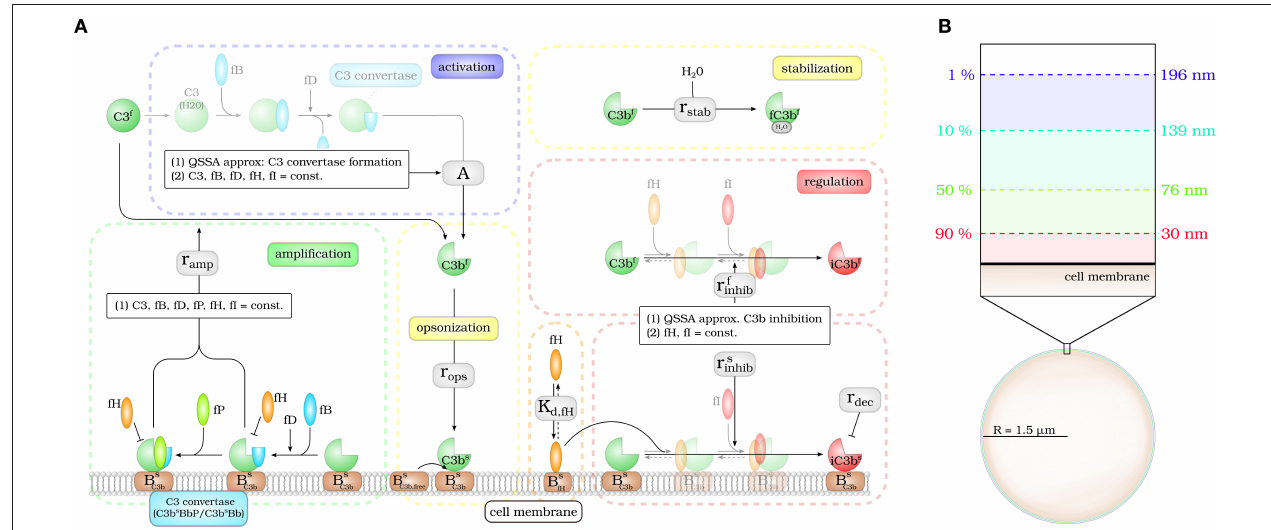
FIGURE 1 | Hybrid differential equation model of the complement system. Complement activation can be divided into five parts: (i) activation, (ii) opsonization, (iii) stabilization, (iv) amplification, and (v) regulation. (A) The model focuses on the dynamics of the central component C3b : Active C3b in the fluid phase, C3b f , results from cleavage of precursor molecule C3 f . The interaction of the fluid phase molecule C3b f with the cell surface is modeled by the interaction with free surface binding sites B s C3b , free and binding sites B s C3b that are occupied with molecules C3b s on the surface. C3b f that does not bind to the cell surface gets inactivated via a Factor H mediated inhibition process, or gets stabilized by water molecules and is no longer able to bind to the cell surface. Surface-bound C3b s can form C3-convertase molecules— C3b s Bb and C3b s BbP –that cleave C3 f molecules to C3b f molecules in the vicinity of the cell surface. C3b s can be inactivated via an inhibition process that is mediated by surface-bound Factor H, whose concentration depends on the concentration of binding sites on the cell surface B s fH , max . (B) The lifetime of active C3b f is short such that, depending on the distance from the cell surface, the fraction of molecules that reach the cell surface is small; for example, only 1% at a distance of 196nm within a simple decay